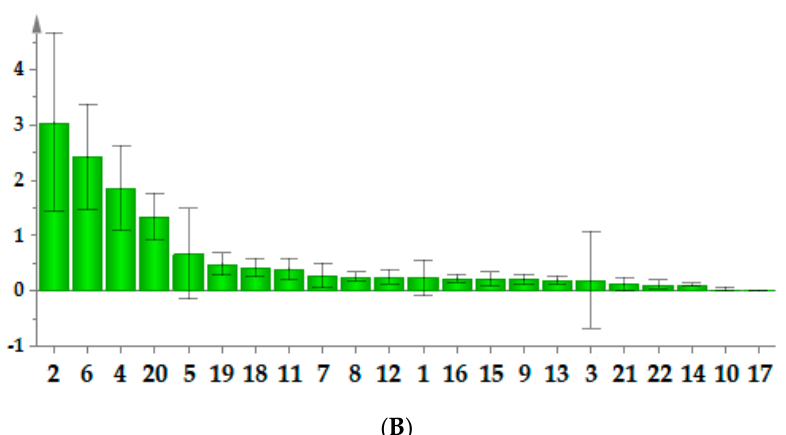
Figure 5. The orthogonal partial least squares discriminant analysis (OPLS–DA) scores scatter plot ( A ) and VIP ( B ) of xylem and phloem in SC.